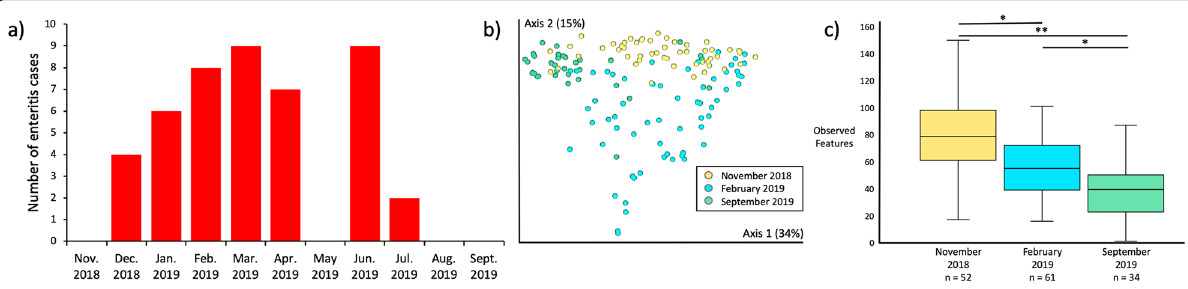
Fig. 1 Seasonality in enteritis and gut microbiota in healthy lorikeets a Number of enteritis cases by month in Columbus Zoo and Aquarium lorikeets. Enteritis samples collected from the same bird within two weeks of the initial enteritis sample were considered a single case. Enteritis samples collected beyond 2 weeks from the initial sample in the same bird were counted as a second case of enteritis. Columbus Zoo & Aquarium healthy birds only: b Microbial community composition (Weighted UniFrac) and c diversity (Observed Features) by season (November 2018, February 2019, September 2019). There were significant shifts in microbial composition by season (PERMANOVA p decreased significantly between November 2018 and September 2019 (Kruskal–Wallis * p < 0.001, ** p < 0.0001). (Also see Additional file 6)